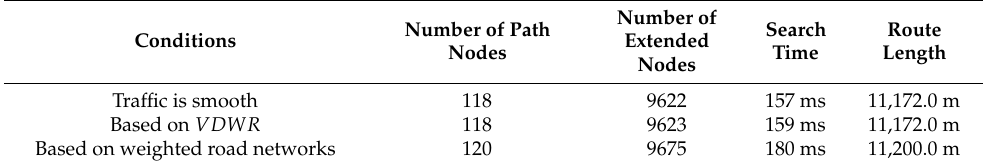
Table 4. Crowded Road is Located Near the Destination While Driving a Relatively Long